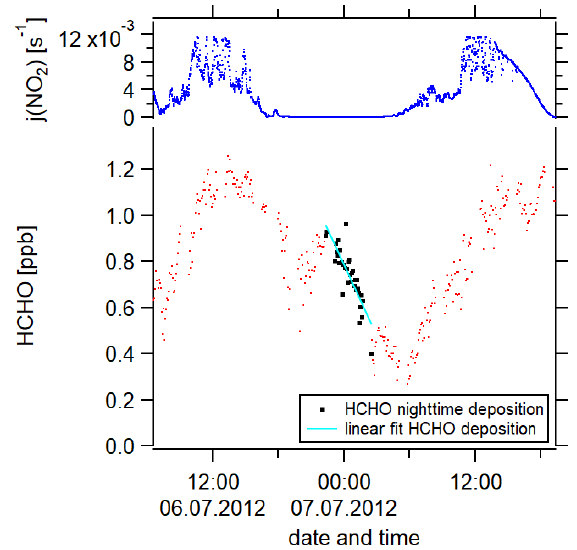
Figure 4. The determination of the deposition velocity is based on the HCHO nighttime loss, which is here exemplarily shown for 1 night during the campaign HOPE (2012) in Hohenpeißenberg, southern